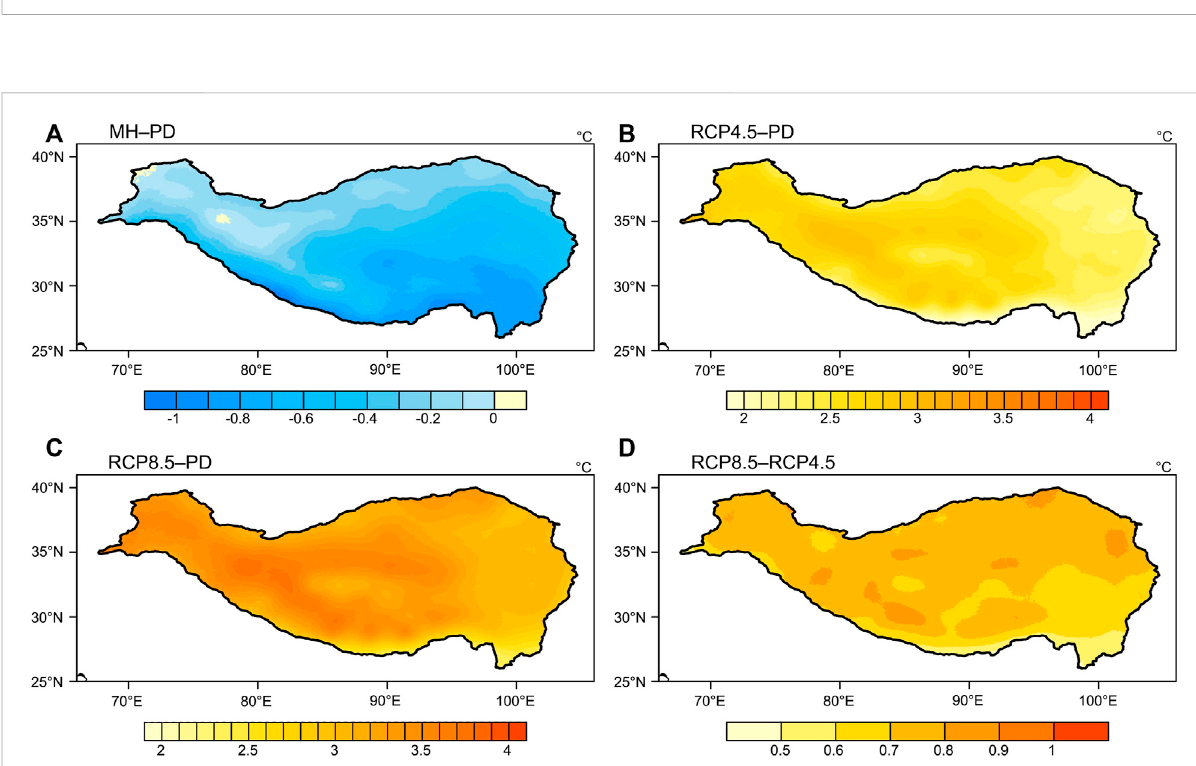
FIGURE 5 Distribution of average annual temperature difference (units: ° C) across TP. (A) MH – PD, (B) RCP4.5 – PD, (C) RCP8.5 – PD, (D) RCP8.5 – RCP4.5.